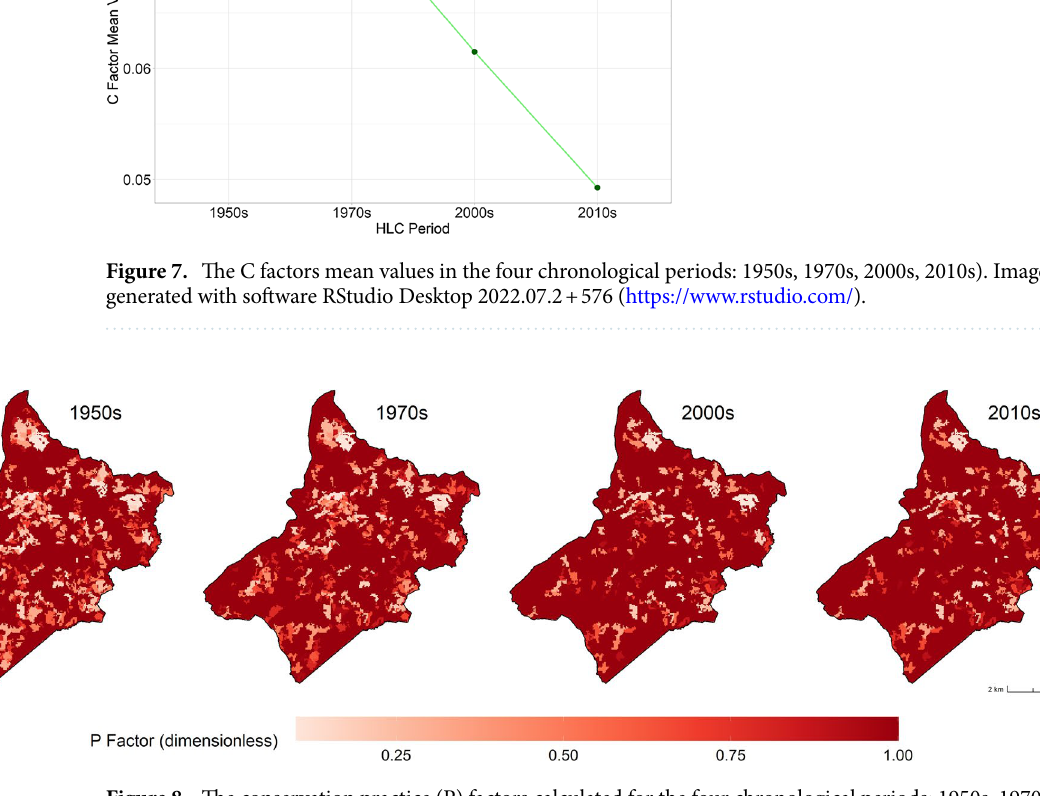
Figure 8. The conservation practice (P) factors calculated for the four chronological periods: 1950s, 1970s, 2000s, 2010s). Image generated with software RStudio Desktop 2022.07.2 + 576 (https:// www. rstud io. com/).